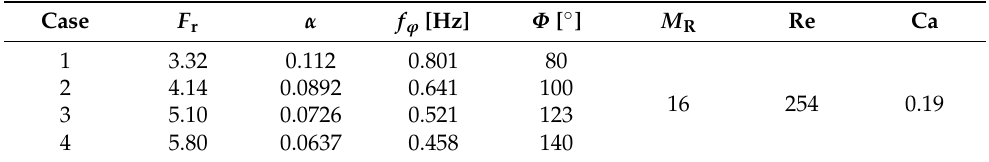
Table 2. The dynamic similarity framework for the systematic investigation of the effect of the flapping frequency on the passive pitching